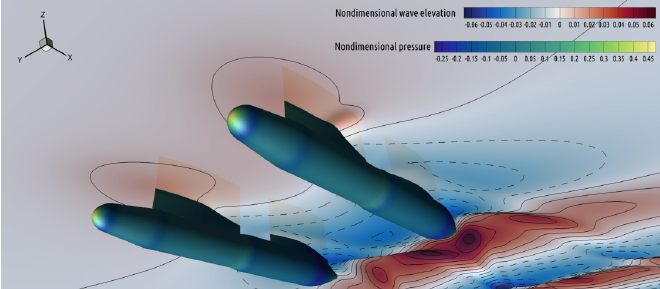
Figure 5. Original SWATH, non-dimensional pressure distribution and wave elevation by potential flow